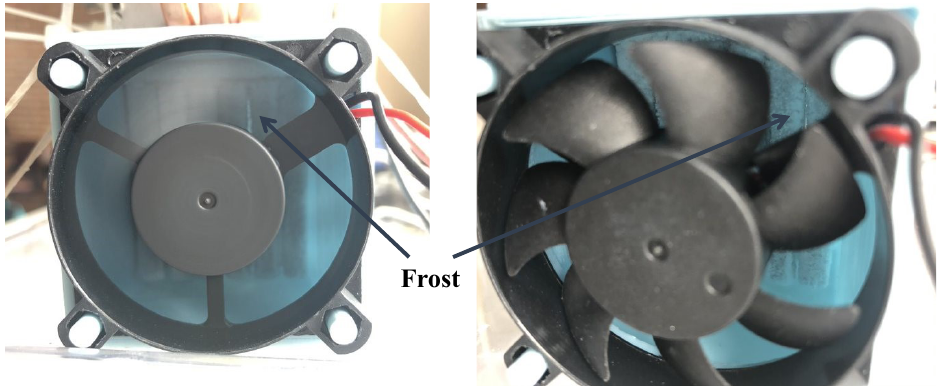
Figure 10. Generated frost on the water condenser